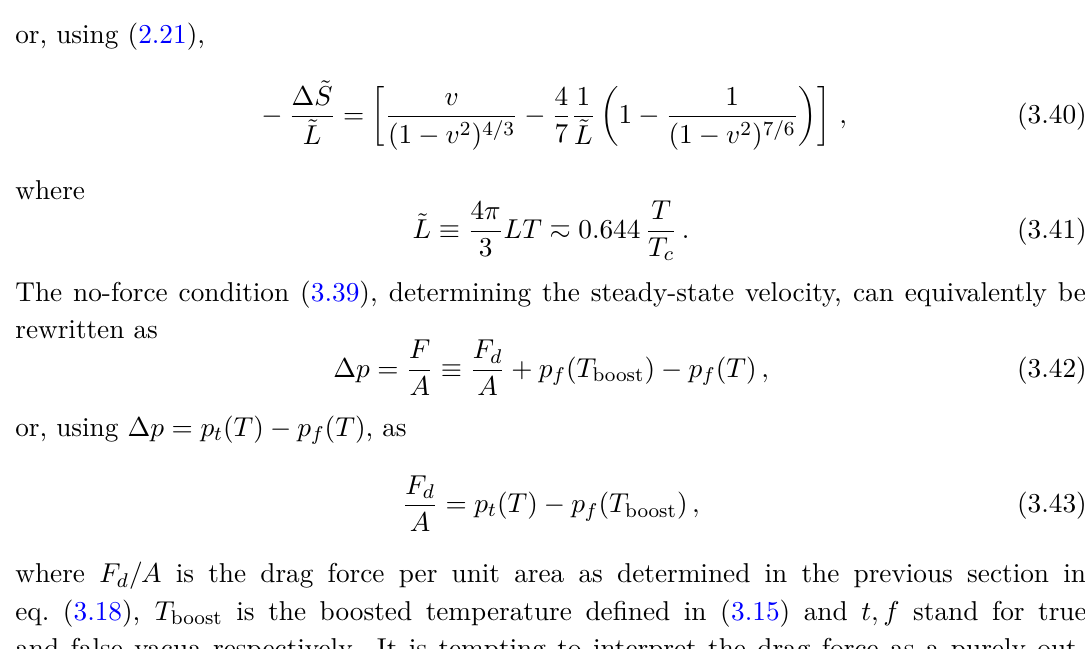
Figure 4 . The bubble wall velocity as a function of the relative temperature T/T c from for- mula (3.40). The constant line is the speed of sound of the flavor sector in the false vacuum, = dp = 1 / 6 c 2 f /dρ f s